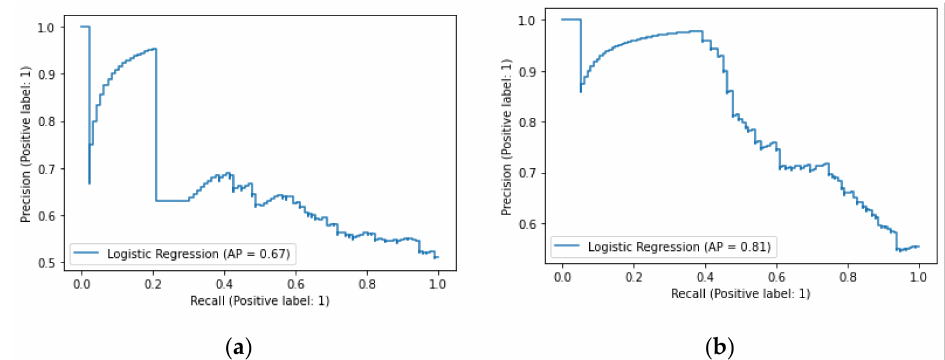
Figure 6. Precision-recall curves for trained classifiers on UC ( a ) and CD ( b ) datasets, basing on CRP level only. Abbreviations: AP, average precision; CRP, C-reactive